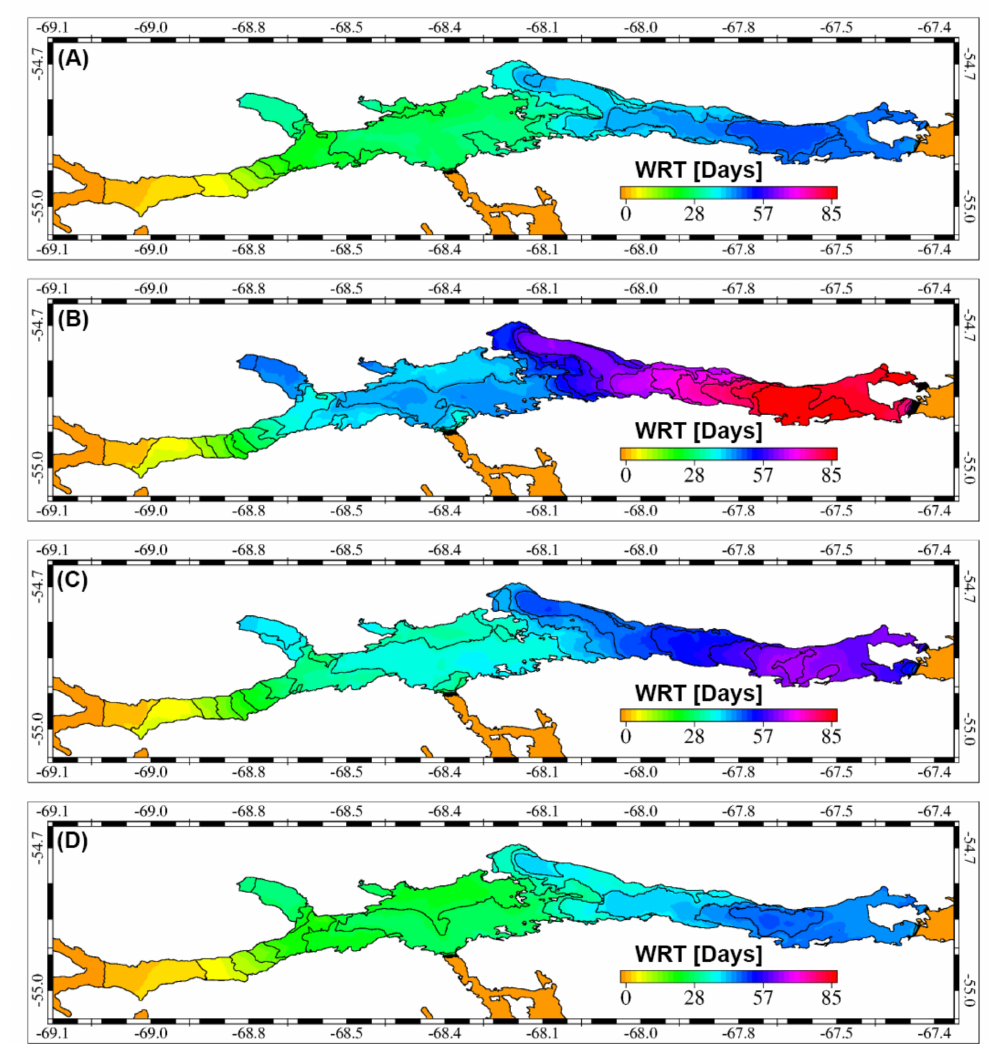
Figure 9. Seasonal water residence times computed for bottom layers. From top to bottom, summer ( A ), autumn ( B ), winter ( C ), spring ( D